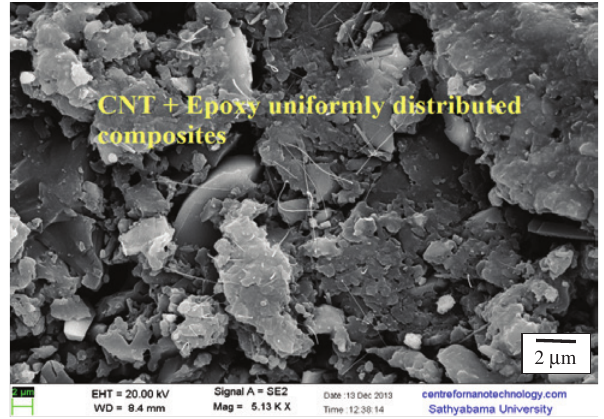
Figure 15: GFRP with CNTs 5% before wear.